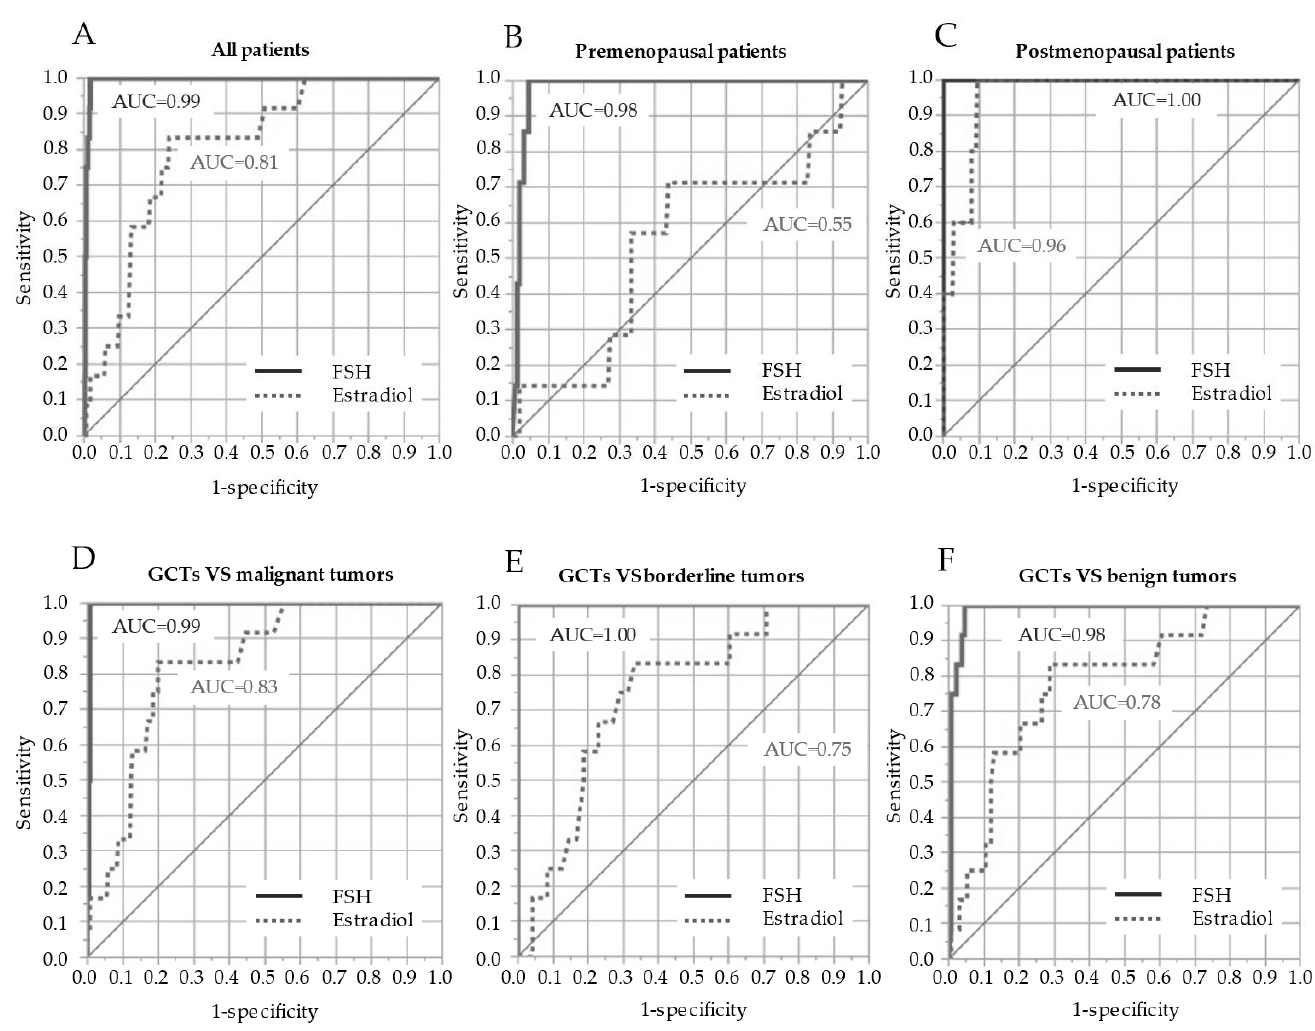
Figure 3. ROC of serum FSH and estradiol levels for the diagnosis of GCTs in all ( A ), premenopausal ( B ), and postmenopausal patients ( C ). ROC between GCTs and malignant tumors ( D ), GCTs and borderline tumors ( E ), and GCTs and benign tumors ( F ) according to malignancy. ROC, receiver operating curves; AUC, area under the curve GCT, granulosa cell tumor; FSH, follicle-stimulating